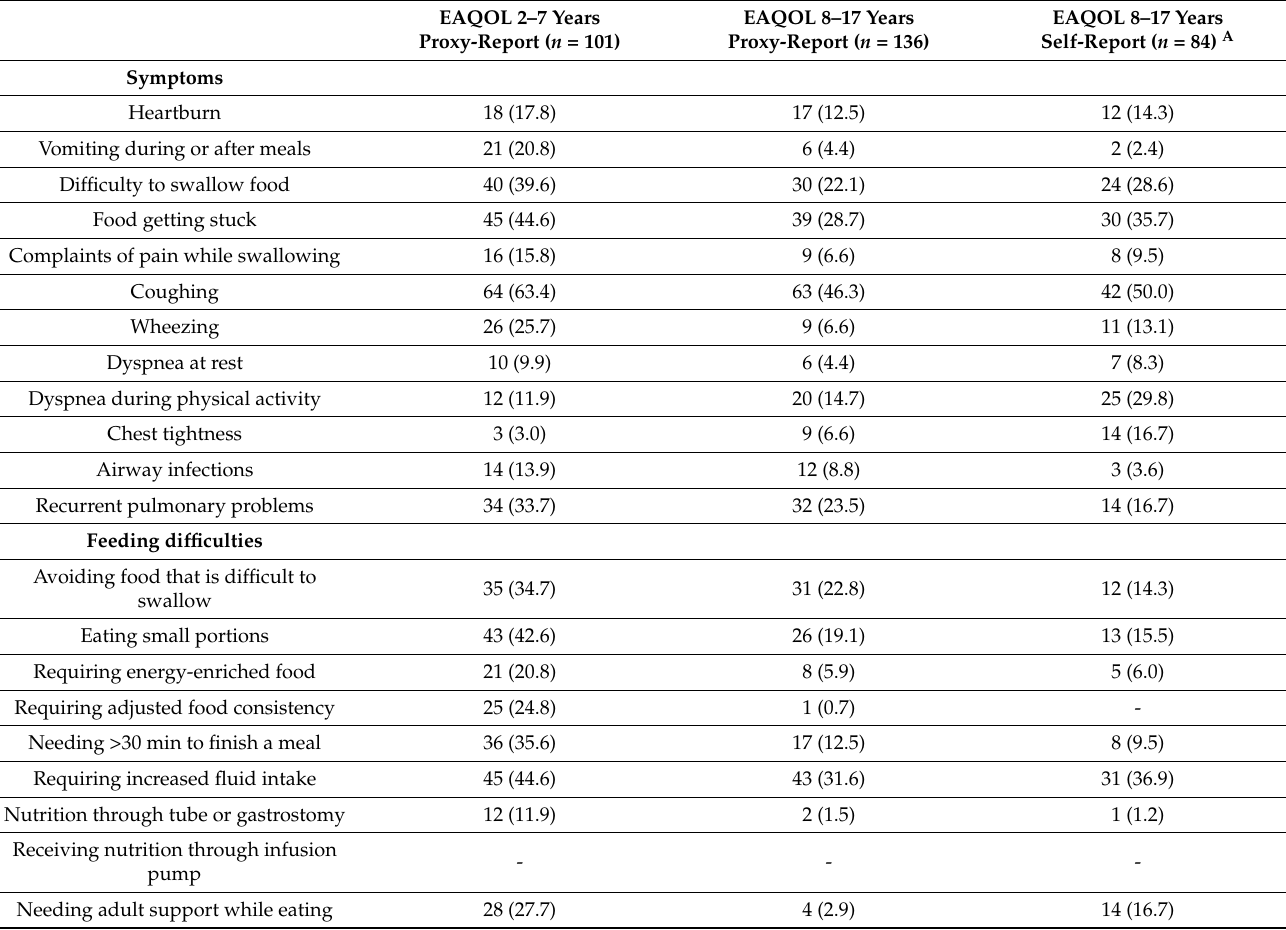
Table 2. Digestive symptoms, respiratory symptoms, and feeding difficulties in the four weeks prior to filling out the questionnaires, presented as n (%). A Only children ≥ 12 years old reported these